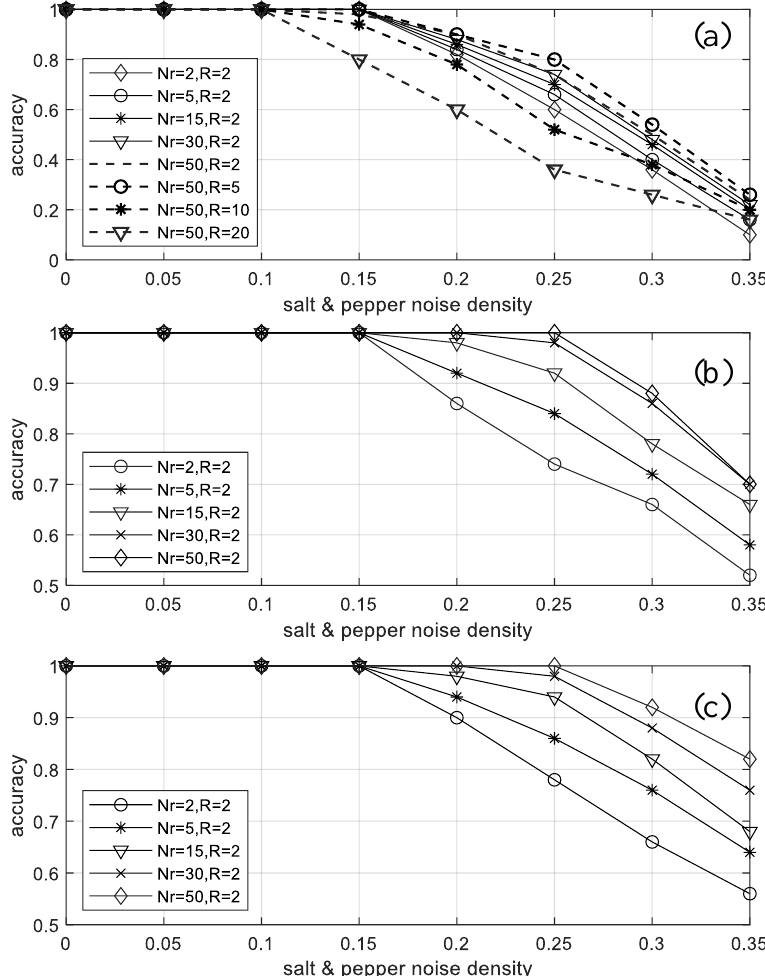
Figure 14. Accuracy vs. salt and pepper noise density for ( a ) centre, ( b ) rotation, and ( c ) scale under various R and N r in Figure 5 for the proposed RV-GHT using the Monte Carlo